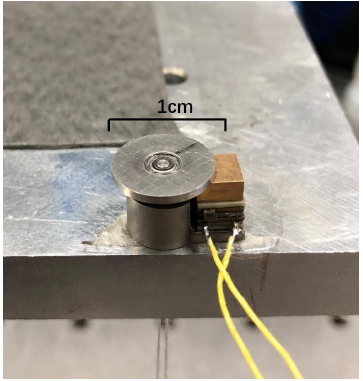
Figure 8. Prototype of the micro-piezoelectric actuator.